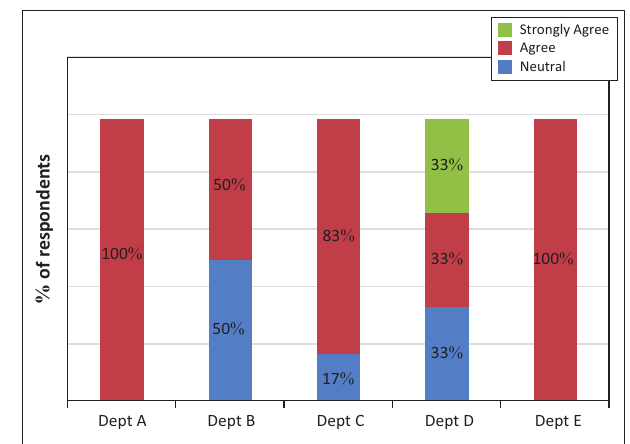
FIGURE 7: Online Research Output Submission System is a useful